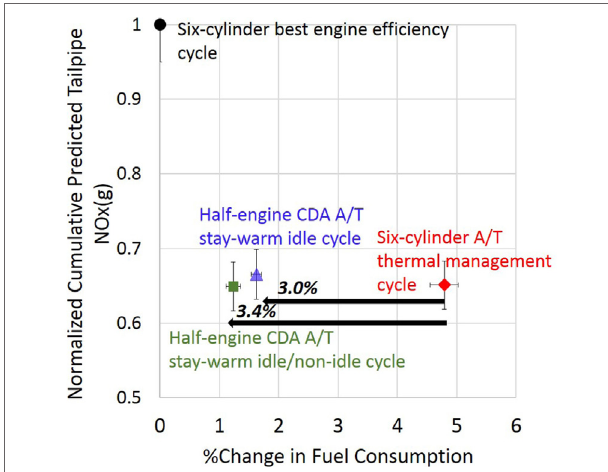
FigUre 14 | Up to 3.0% improvement in fuel consumption can be obtained by implementing CDA at loaded idle sections of the HD-FTP. Moreover, 3.4% improvement can be obtained by implementing CDA at appropriate non-idle sections along with loaded idle sections. The ability of CDA to maintain A/T temperature is reflected in the form of nearly equal/lower tail pipe out NOx as compared to Six-cylinder thermal